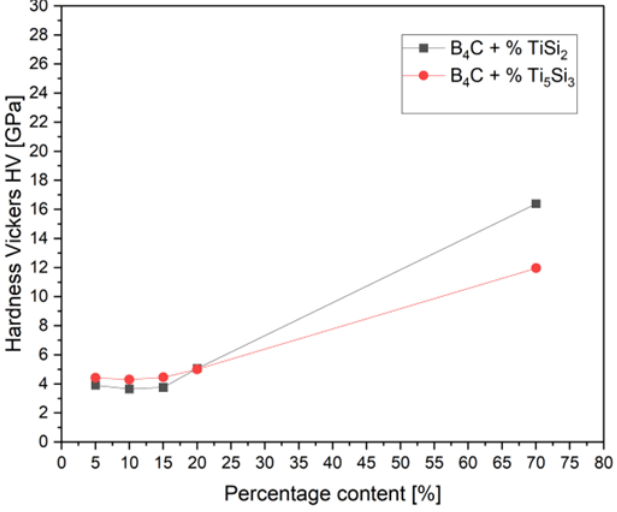
Figure 4. Hardness of the composites as a function of the percentage of various additives.